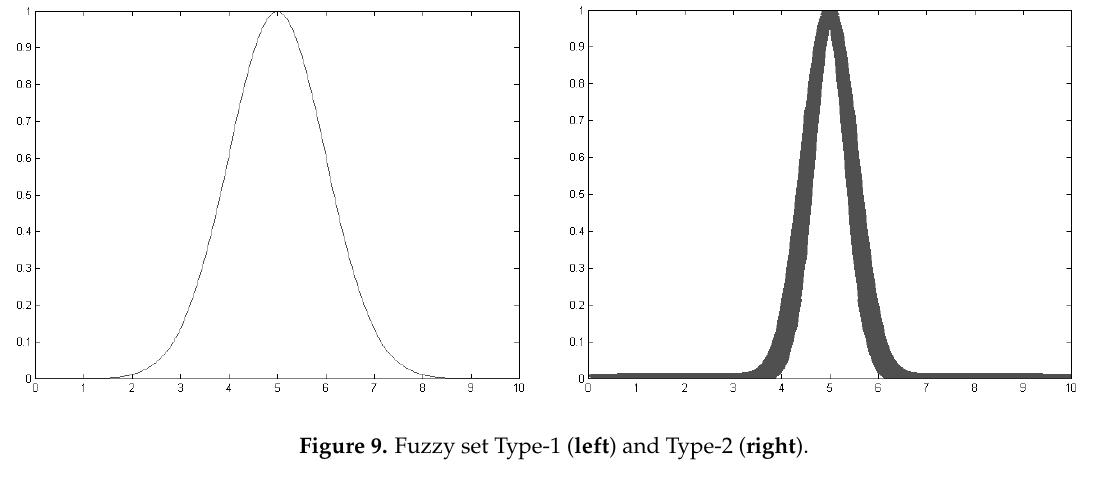
Figure 9. Fuzzy set Type-1 ( left ) and Type-2 ( right